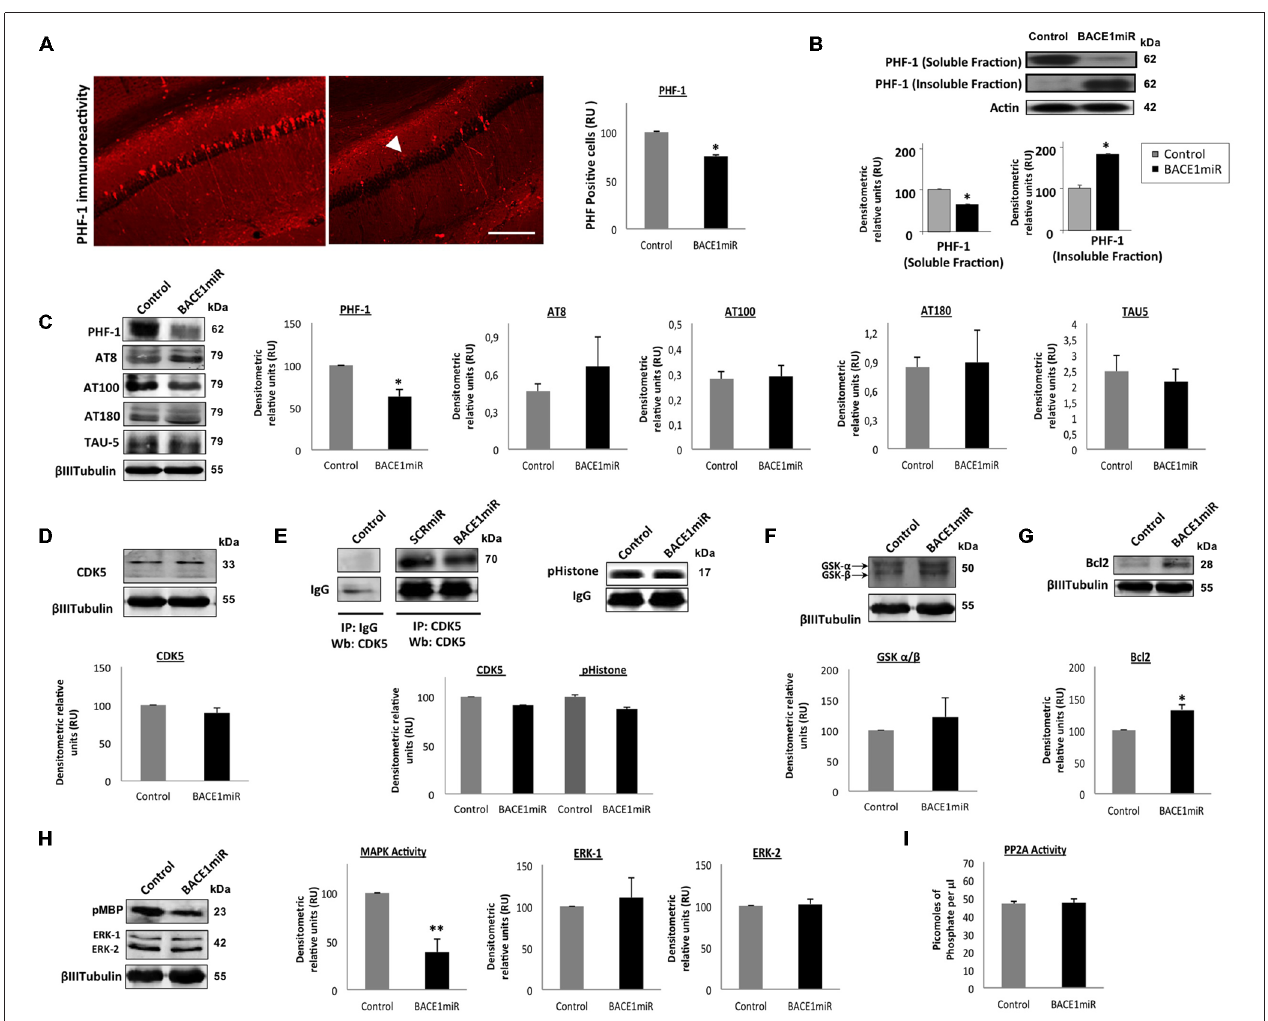
FIGURE 3 | BACE1miR reverses hyper-phosphorylated tau in the hippocampus of 3xTg-AD mice. (A) The number of PHF-positive cells in the CA1 region of the hippocampus of 18-month-old 3xTg-AD mice that were treated with AAV2/5-BACE1miR or AAV2/5-GFP as control for 6 months. The white arrowhead shows a significant decrease in immunoreactivity. Representative confocal-DSU images ofimmunofluorescence are shown. Red: Alexa 594, 10 × magnification, scale bar: 20 µ m. n = 3, ∗ p < 0.05. (B) Representative bands of the soluble and insoluble fractions of tau. n = 3, ∗ p < 0.05. (C) Levels of the hyperphosphorylated tau (PHF-1, AT8, AT100, AT180 and TAU-5) protein from the hippocampi of 18-month-old 3xTg-AD mice at 6 months after injection with AAV2/5-BACE1miR or AAV2/5-GFP as control. Representative blots are shown. RU = relative units. n = 4, ∗ p < 0.05. (D) CDK5, (E) CDK5 activity, (F) GSK3- β , (G) Bcl-2, (H) MAPK activity and ERK-1/ERK-2 protein levels were detected. (I) Protein phosphatase 2 (PP2A) activity was quantified using the PP2A Immunoprecipitation (IP) Phosphatase Assay Kit (Millipore), which detects picomoles of phosphate per microliter. n = 4, ∗ p < 0.05. Representative blots are shown. RU = relative units. n = 4, ∗ p < 0.05, ∗∗ p <